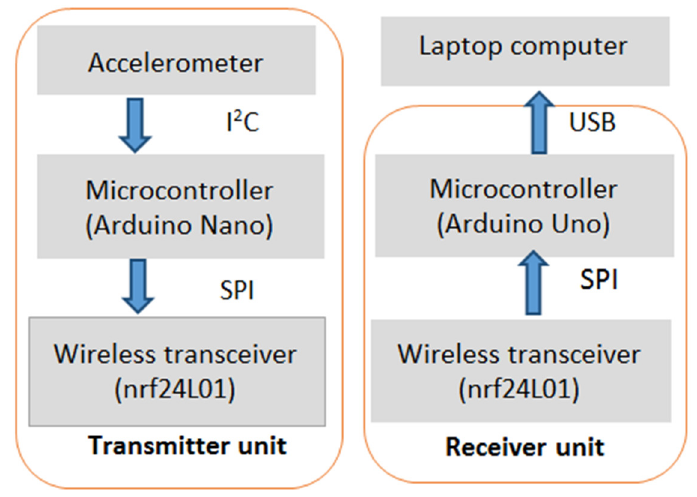
Figure 3. Data recording transmitter and receiver units.